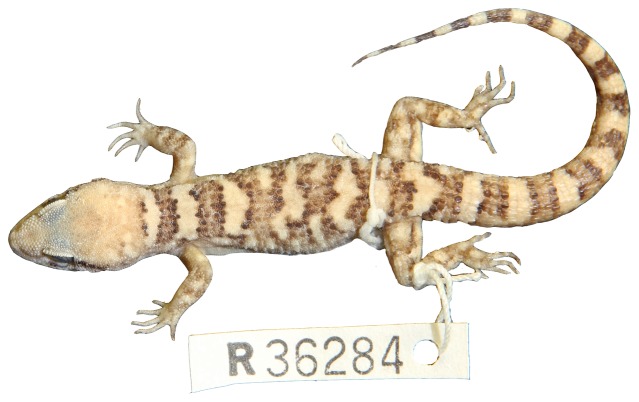

Heteronotia fasciolatus sp. nov. (holotype, NTM R36284).